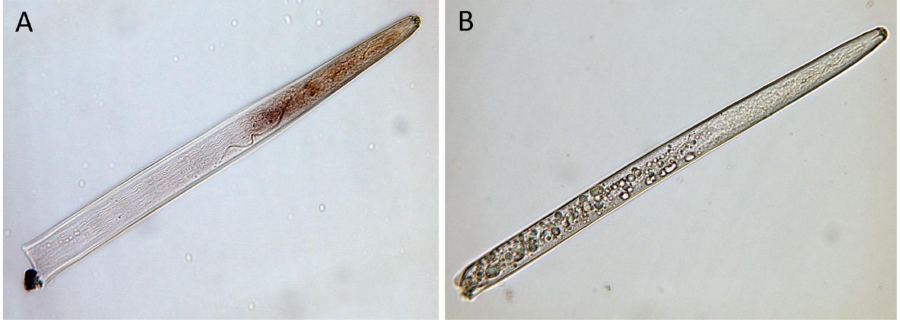
Figure 4. Localization of Pl-eng -2 in P. loosi by in-situ hybridization ( A ). No staining is observed with the sense probe ( B